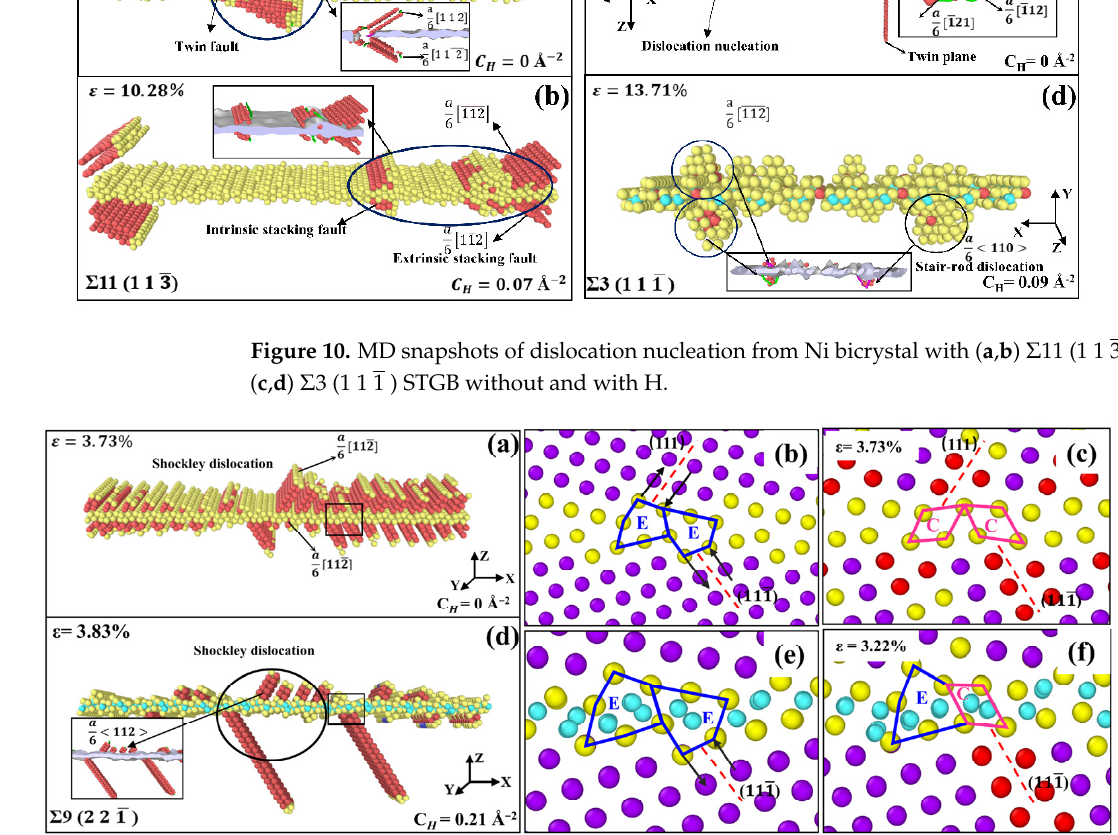
(cid:10) (cid:11) 110 STGBs. As it has